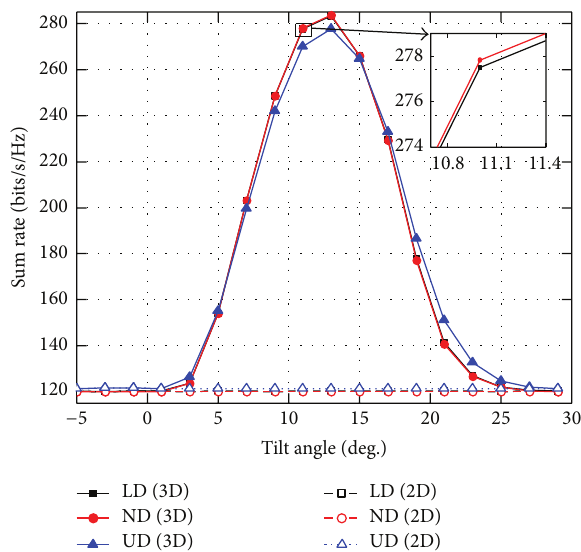
Figure 2: Simulated sum rate against the SNR for uniform distribu- tion ( 𝑁 𝑟 = 50 , 𝑁 𝑡 = 2 , 𝐿 = 3 , 𝐾 = 24 , 𝐷 = 200 m, 𝑅 = 100 m, 𝜐 = 4 , and 𝛽 𝑎 = 5 ∘ ,10 ∘ ,13 ∘ ,18 ∘ ,25 ∘ ).